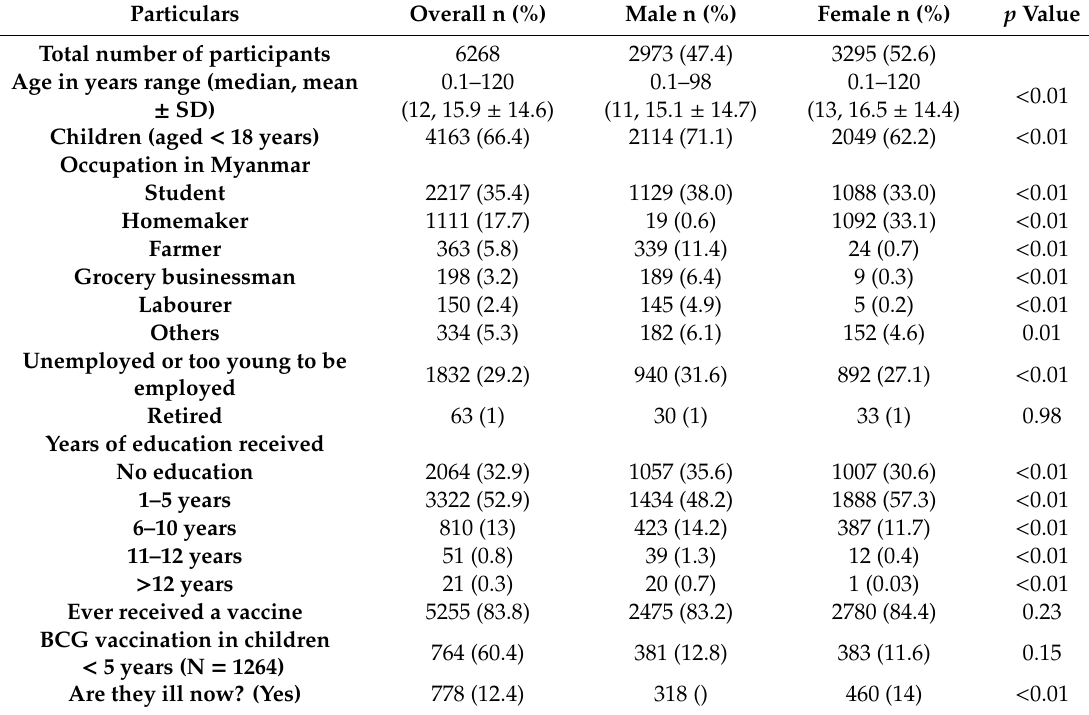
Table 3. Demographic characteristics of family members among Rohingya